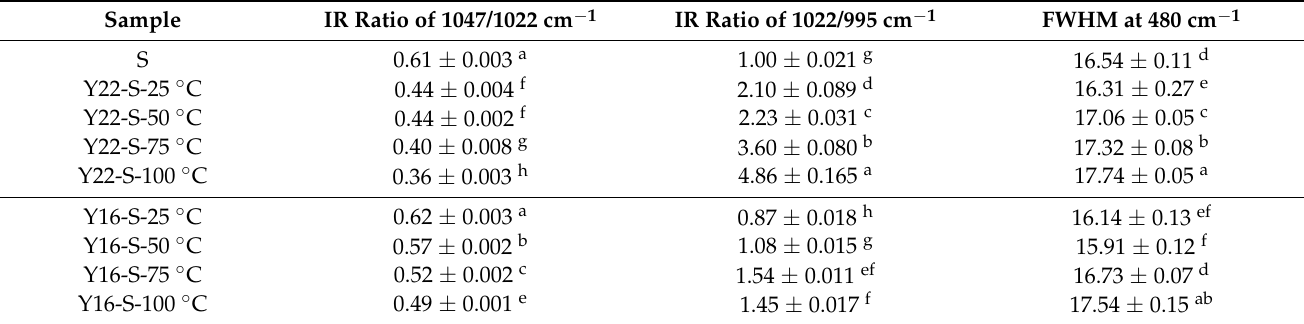
Figure 1. XRD pattern of native starch and different starch–gluten mixtures during heating (RC, relative crystallinity). Table 2. Short-range molecular orders of starch in native starch and different gluten–starch mixtures during heating determined by ATR-FTIR and Raman